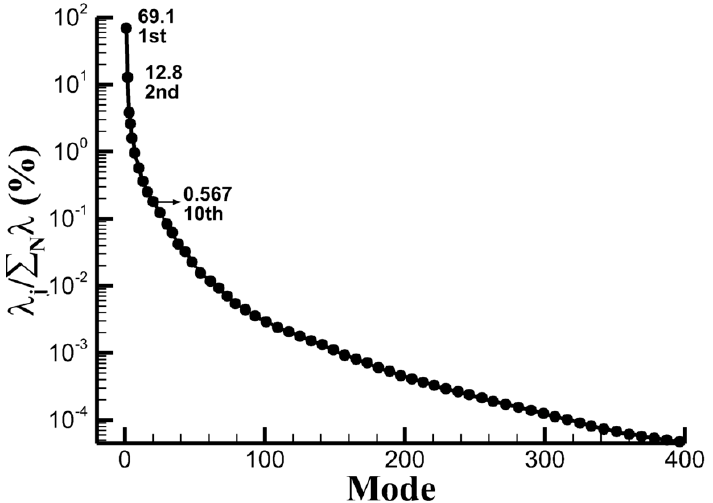
Figure 9. Percentage of each POD mode energy.